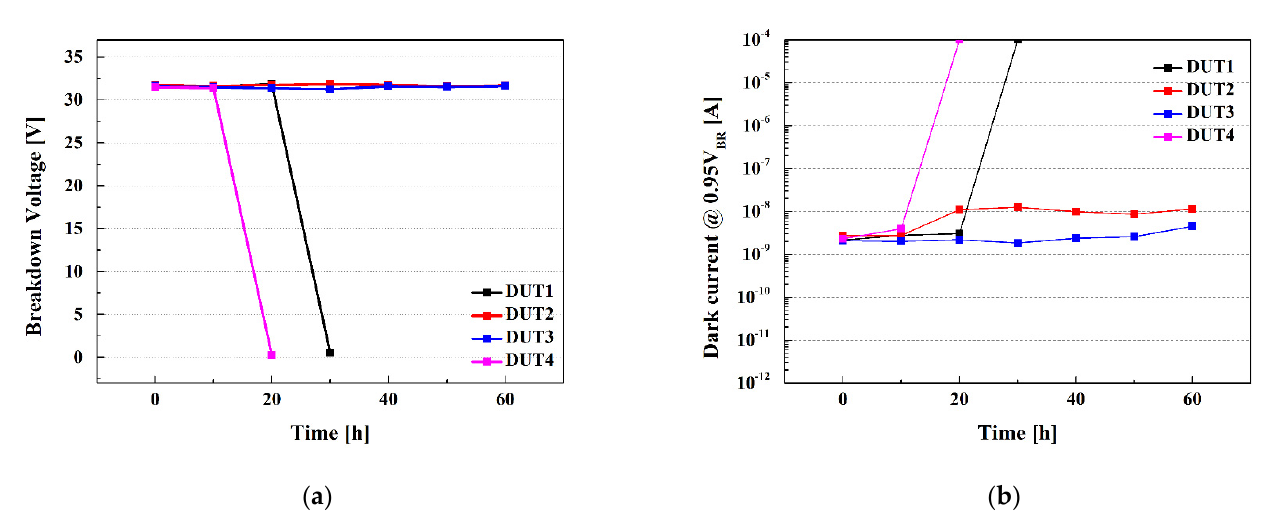
Figure 6. Monitored electrical characteristics of the ( a ) breakdown voltage (V BR ) and ( b ) dark current (I D ) at 448 K with 500 µ A.